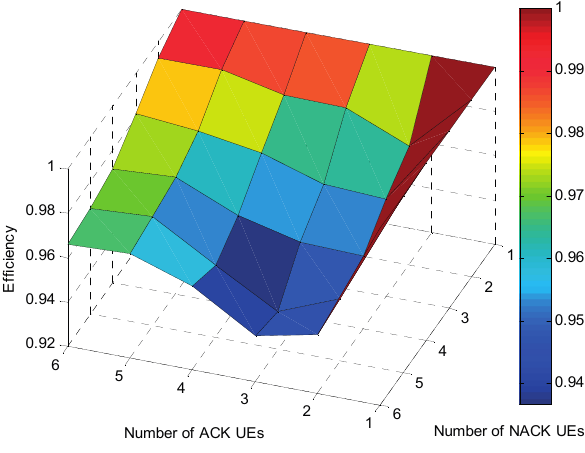
Figure 5. System efficiency: ℰ with different numbers of NACK-UEs and different numbers of